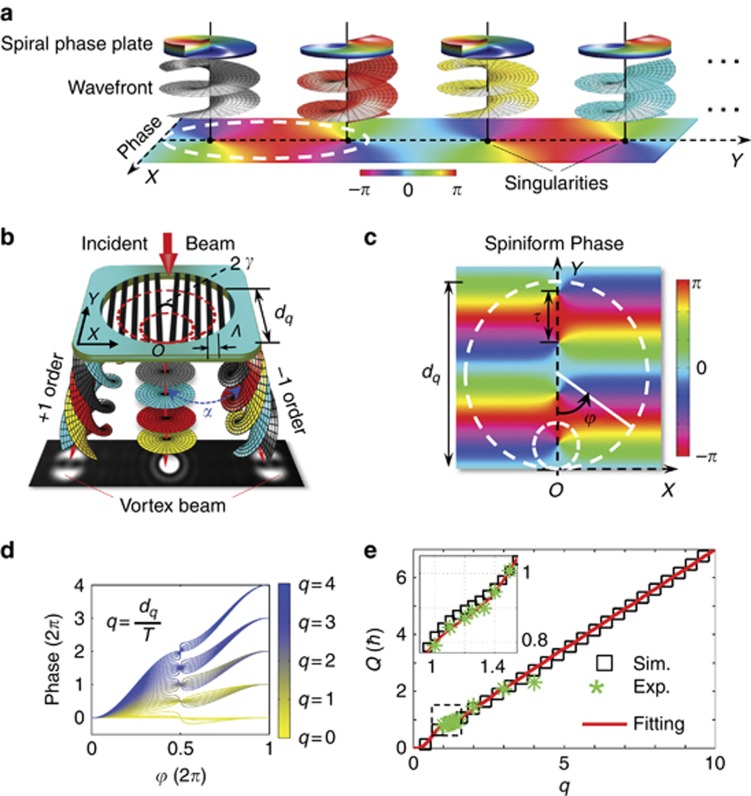
Mechanism of the analog vortex transmitter. (a) Light obtains a helical wavefront with spatially separated phase singularities (black dots) by passing through four transversely located SPPs. (b) Sketch of the transmitter composed of two inclined (inclination angle of γ) gratings with a period of Λ at both sides and a circular aperture of varying diameter (dq), which geometrically acts as an excircle (red dashed circles) tangent to the x-axis at a reference point O. (c) Phase profile encoded into the vortex transmitter. τ denotes the spatial distance between two neighboring phase singularities. φ is the angle coordinate of the circular aperture and increases anticlockwise from φ=0 (negative y-axis) to 2π. (d) Phase along the circumference (dashed circle in (d)) of the circular aperture for its corresponding q. The phase at φ>π is unwrapped by adding 2π. The curves denote the phase values for q (distinguished by the curve colors). (e) The average OAM (Qћ) of a photon as a function of q. The fitting curve (solid red line) of the simulated results (black square boxes) exhibits a root mean square error of 0.04, while the experimental results are denoted by greenish asterisks. Inset: Zoom-in of the data between q=1 and q=1.5.